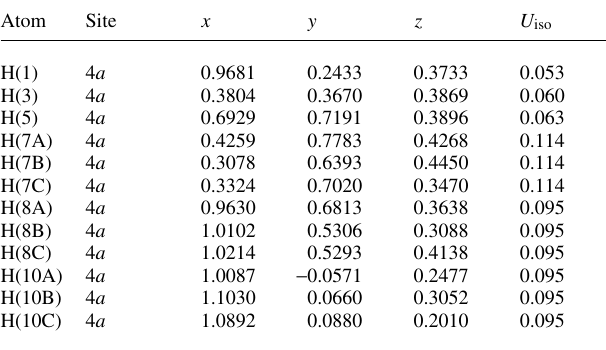
Table 2. Atomic coordinates and displacement parameters (in Å 2 )